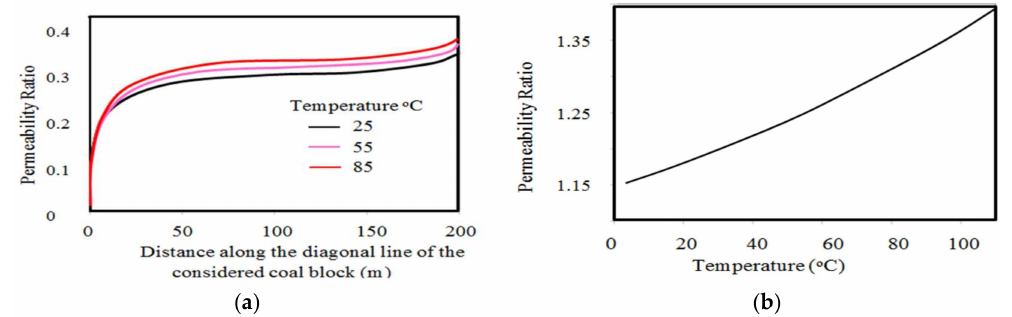
Figure 14. Influence of temperature on CO 2 flow ability in coal at various CO 2 injection pressures [62]. ( a ) 7 MPa CO 2 injection pressure; ( b ) 10 MPa CO 2 injection